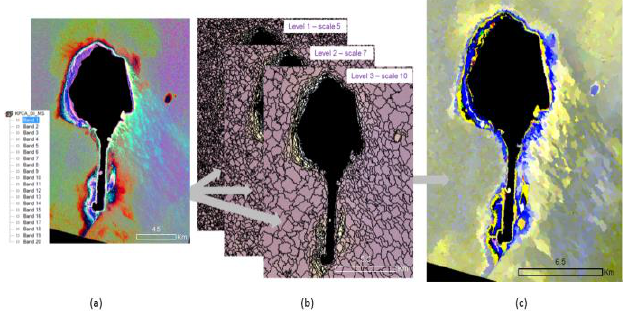
Figure 1. Results from the processing steps of the spectral-spatial method